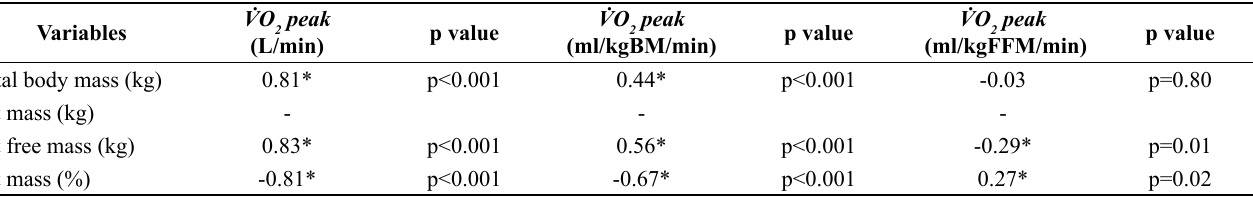
peak and body composition variables (n=80) analyzed taking into account the fat 2